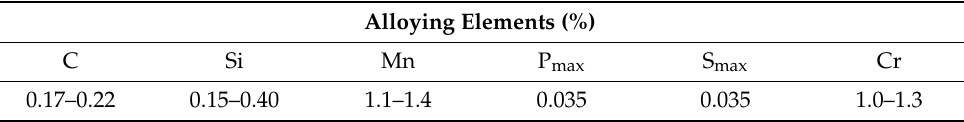
Table 1. Chemical composition of the steel used for